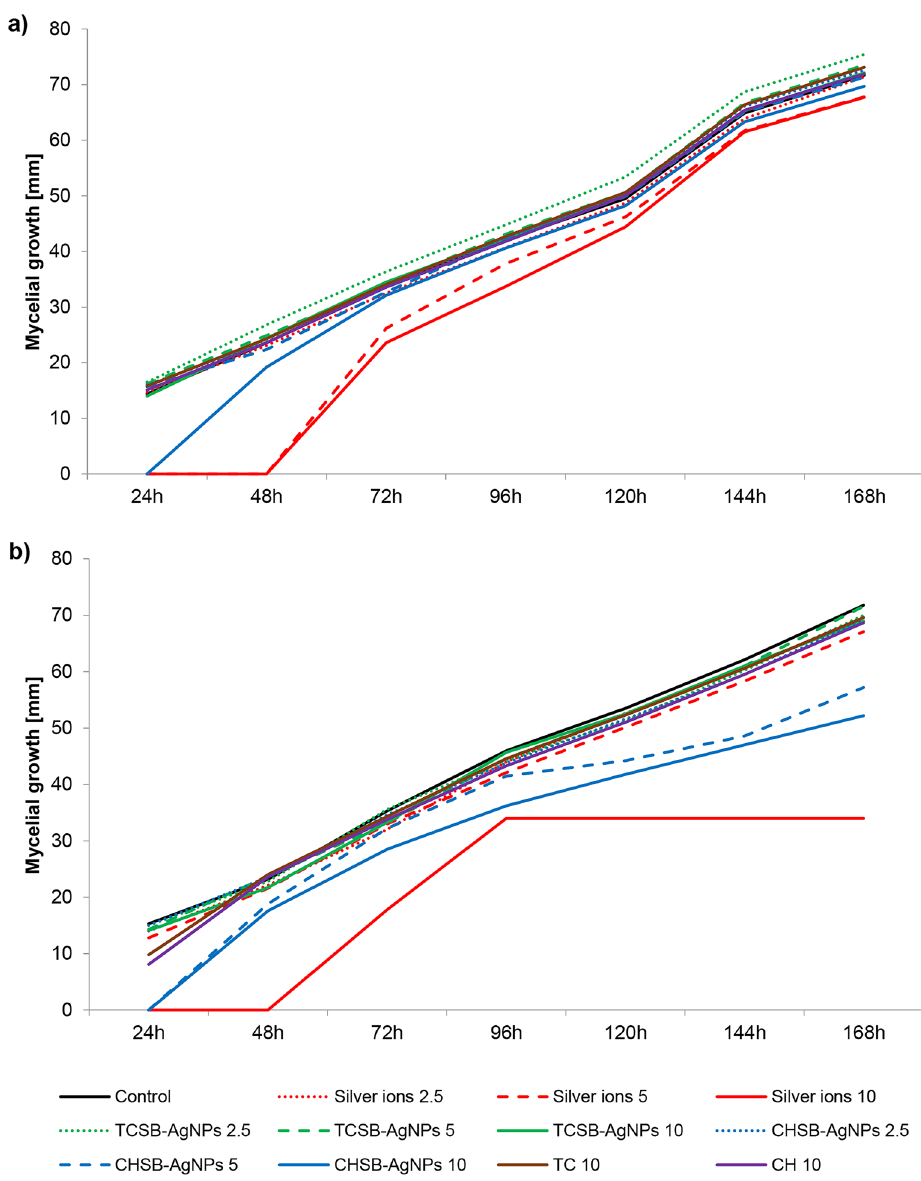
Figure 1. The impact of silver ions, AgNPs and stabilizing agents on the mycelial growth of F. avenaceum over 24 h ( a ) and 240 h ( b ) of the exposure period. The number given for each treatment represents the concentration expressed in mg L −1